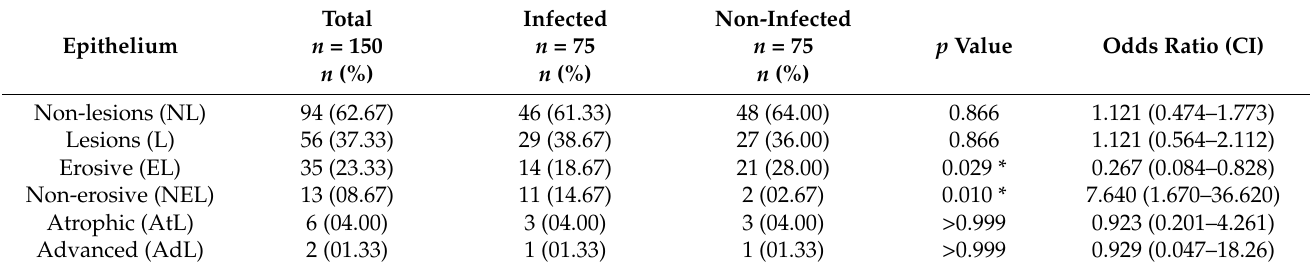
Table 2. Gastric epithelium status of the infected (case) and non-infected with H. pylori (control)